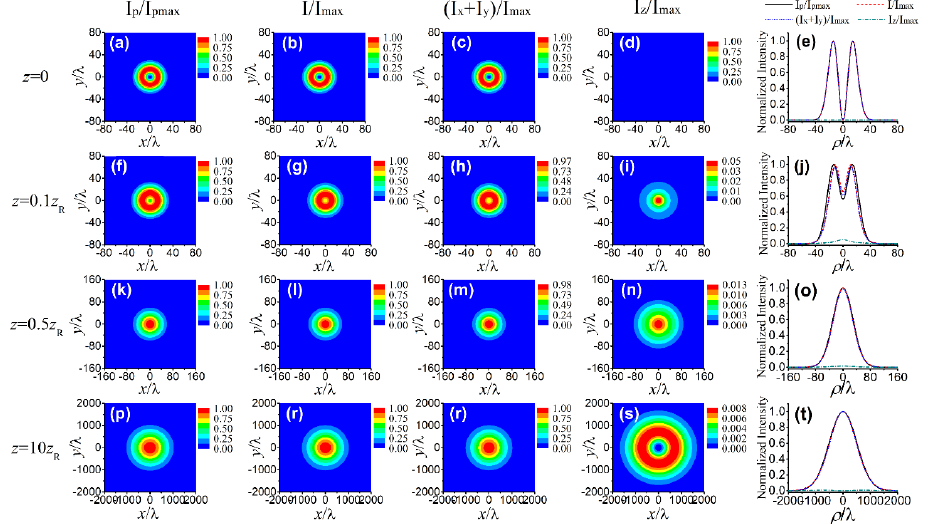
Figure 4. Intensity distributions of the paraxial partially coherent radially polarized (PCRP) beam and the nonparaxial PCRP beam at the propagation distances z = 0(first row), z = 0.1 z R (second row), z = 0.5 z R (third row), z = 10 z R (fourth row) in free space, where z R is the Rayleigh distance. First column: the total intensity I p for the paraxial SCRP beam. Second column: the total intensity I for the nonparaxial SCRP beam. Third column: the transverse intensity I x + I y for the nonparaxial SCRP beam. Fourth column: the longitudinal intensity I z for the nonparaxial SCRP beam. Fifth column: (cid:112) x 2 + y 2 . Here, the beam width σ 0 = 10 λ , and the the corresponding cross lines ( y = x ) with ρ = intensities are normalized with respect to their